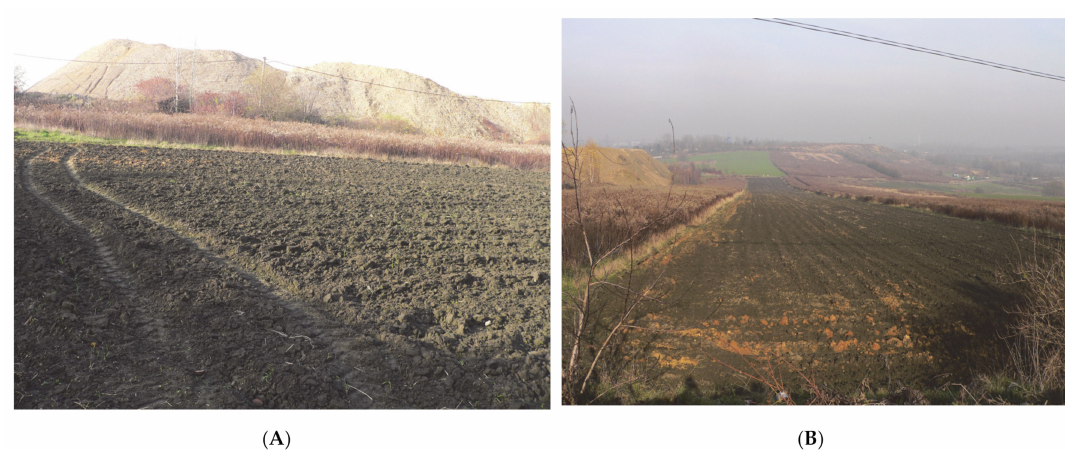
Figure 1. Sampling sites, ( A ) arable land neighboring the Zn-waste and ( B ): whole sampling zone (about 1000 m